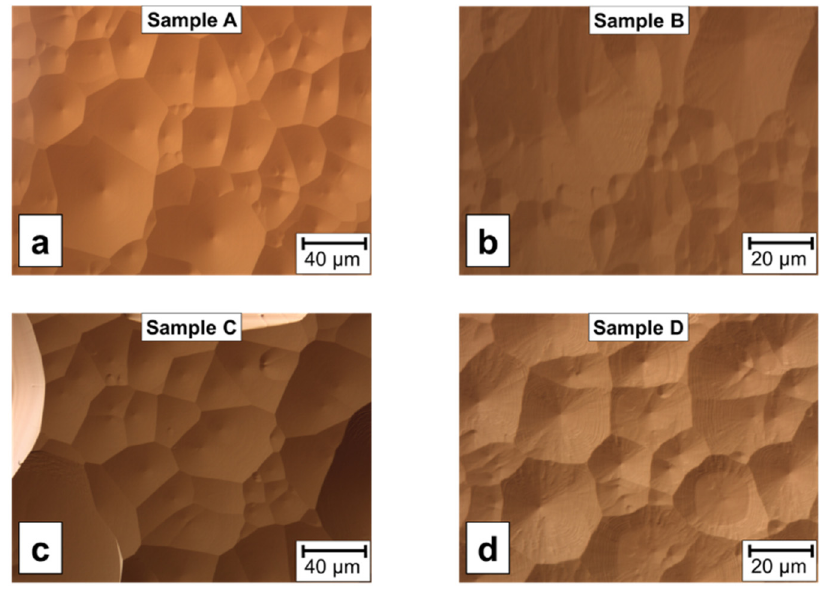
Figure 1. Nomarski microscopy images of surface morphology for ( a ) sample A, ( b ) sample B, ( c ) sample C, and ( d ) sample D.